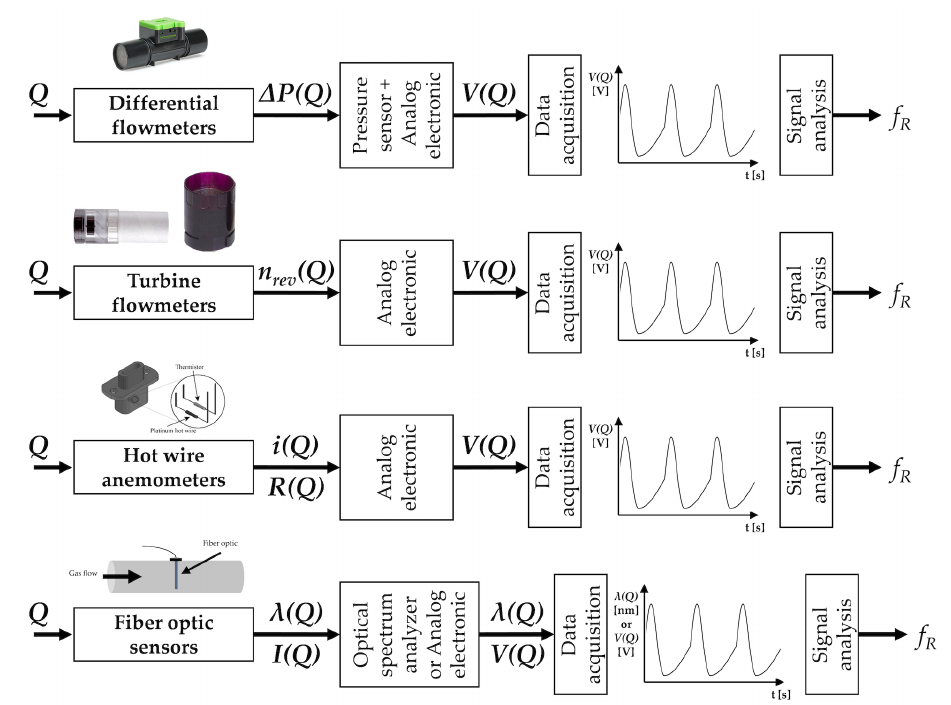
Figure 2. Airflow sensors: the main elements composing the measuring chain (sensor, analog electronics, data acquisition, post-processing or signal analysis stage) to estimate f R . Analog electronic stages vary between different flowmeters because the output quantities are different. ∆ P ( Q ) , n rev ( Q ) , i ( Q ) , R ( Q ) , λ ( Q ) , I ( Q ) are pressure drop, turbine revolutions per minute, current, resistance, wavelength, and light intensity changes caused by the airflow ( Q ), respectively. V ( Q ) is the voltage output. The DF figure is from Sensirion [33]; the turbine flowmeter figure is from MIR [34]; the